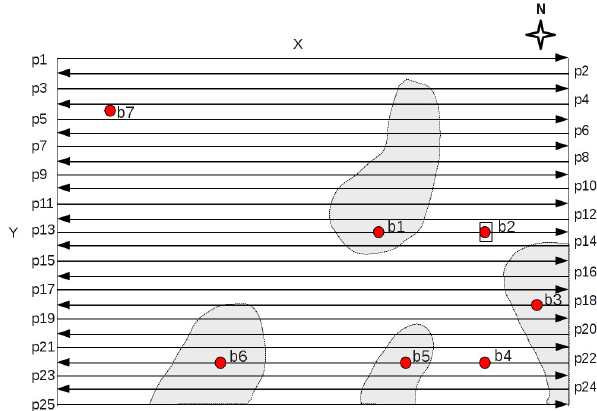
Fig. 3. A schematic of the field site with patterned crops (45m × 36m) and the survey design. The grey areas indicate smaller wheat than that at the other area. Lateral lines and red circles are the route measurements of GPR survey and boreholes, respec- tively. The small box on p13 indicates the soil profile